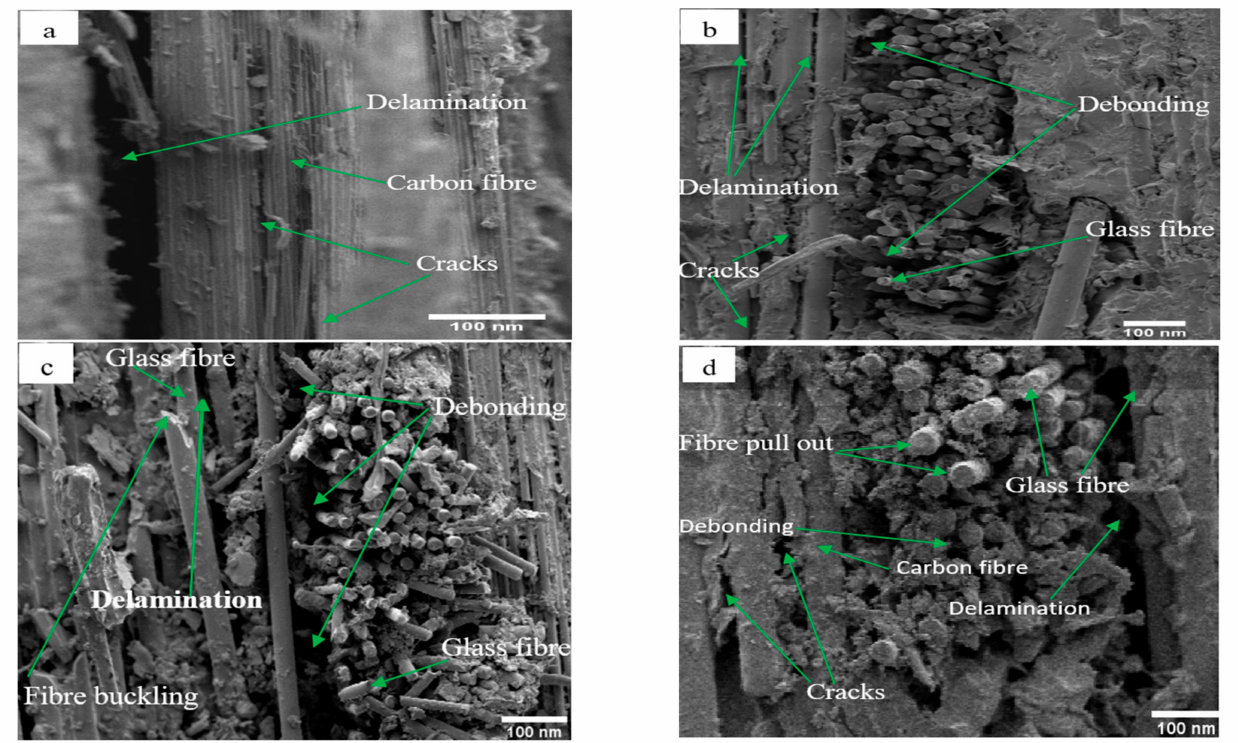
Figure 8. SEM images of bidirectional carbon ( a ), glass ( b ), glass–carbon ( c ), and glass–carbon– glass ( d ) composite laminates during room temperature